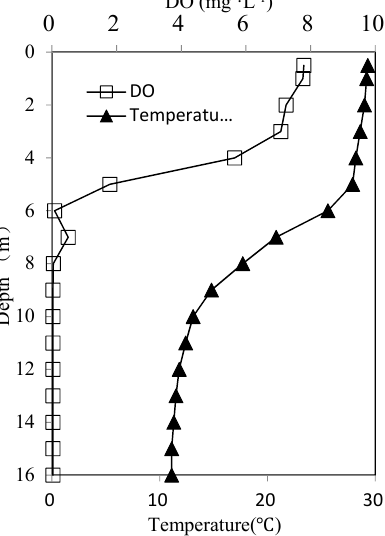
Figure 2. Dissolved oxygen (DO) and temperature profile in the Zhoucun Reservoir at the time of stratification.